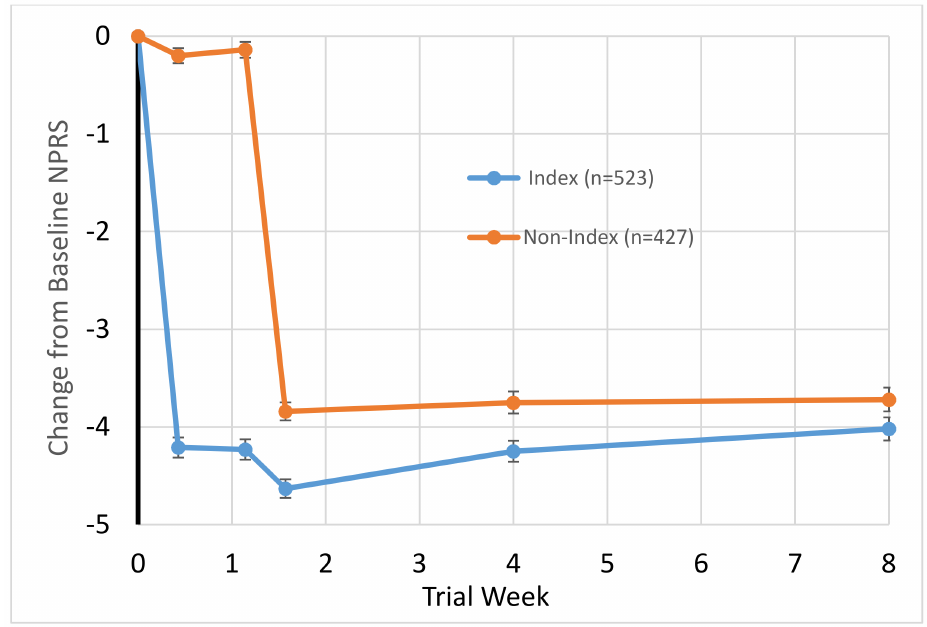
Figure 4. Graph of the change in pain while walking (assessed using an 11-point NPRS on a scale of 0–10) in patients with bilateral knee OA undergoing treatment of the index knee (n = 523) and treatment of the nonindex knee (n = 427). This second injection in the opposite knee was performed 8 days after the first injection into the index knee. The magnitude in pain reduction was similar for the index and nonindex